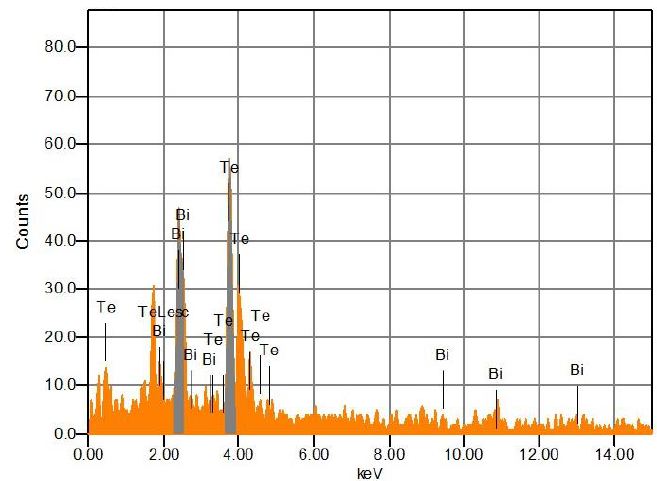
Figure 4. EDS spectrum of Bi 2 Te 3 film deposited by PLD technique.